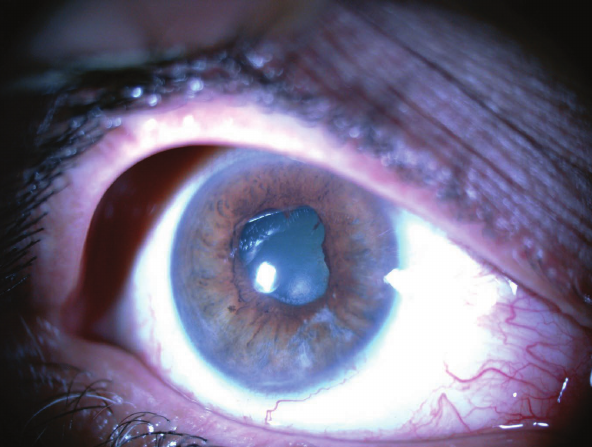
Figure 8. Photo-slit image of the right eye five months after treatment: Complete tumor regression, iris atrophy, localized posterior synechia, and mild cataract